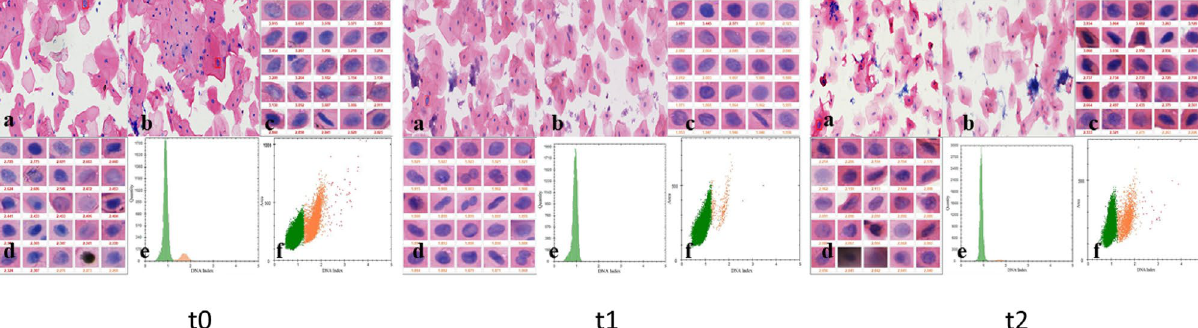
Figure 5. DNA aneuploid analysis of OL patients with severe dysplasia at t0, t1 and t2 (DNA aneuploid analysis in new areas). The cytological classification and diagnosis of YSGG-PDT in patients with severe dysplasia at t0, t1, and t2 were analyzed by TCT. DNA ploidy was used to analyze the changes of cell DNA ploidy at t0, t1, and t2 in YSGG-PDT treatment of OL patients with severe dysplasia. ( a The staining quality of cell smear preparation (Staining Feulgen, lens ×100); b the morphology of normal cells (Staining Feulgen, lens ×100); c the morphology of abnormal oral cells (Staining Feulgen, lens ×400); d other abnormal cells, including pathogenic microorganisms (fungi, trichomonas, parasites, etc.) (Staining Feulgen, lens ×400); e the histogram shows the distribution of cells of different volumes and abnormal cell peaks (double peaks, three peaks, multiple peaks, abnormal peaks, etc.); f the scatter diagram shows the number of cells of different DNA ploidy.)